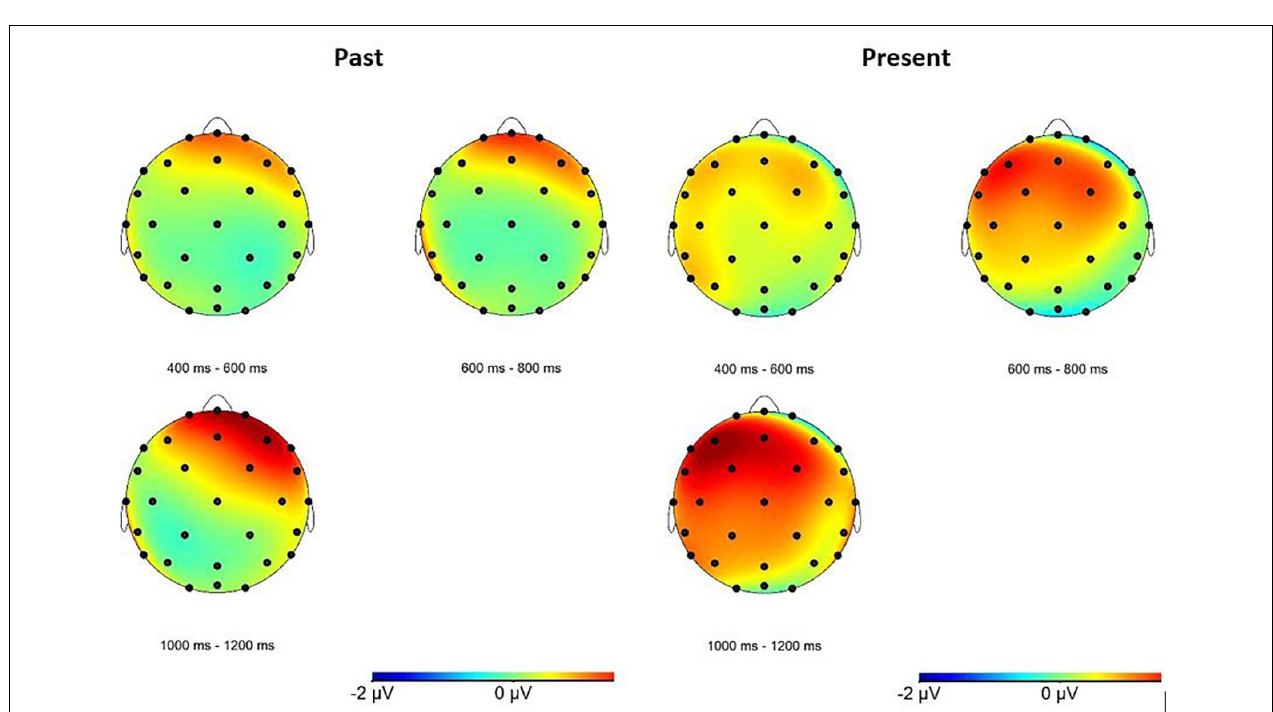
FIGURE 5 | Topographic maps indicating the ERP positive effect for past and present verb